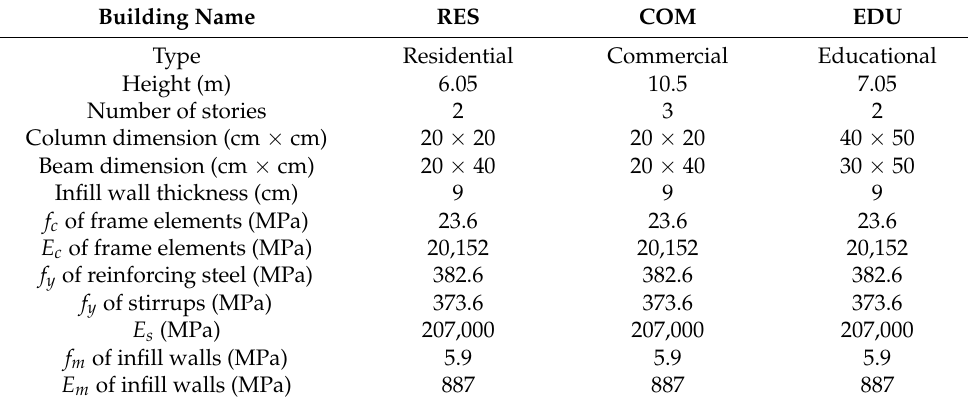
Table 4. Structural properties of representative buildings.